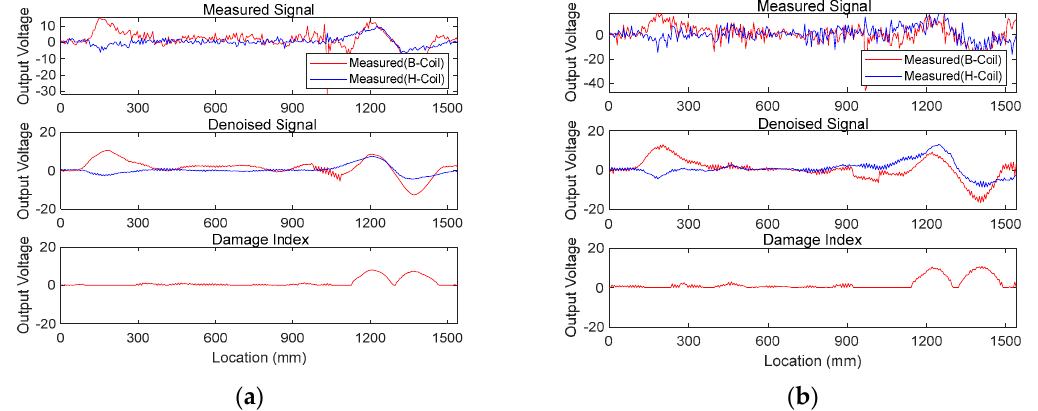
Figure 9. Measured ( top ) and denoised signals ( middle ) with computed damage index ( bottom ) for: ( a ) TSL1-1 with 2.86% sectional loss; ( b ) TSL2-1 with 5.71% sectional loss.